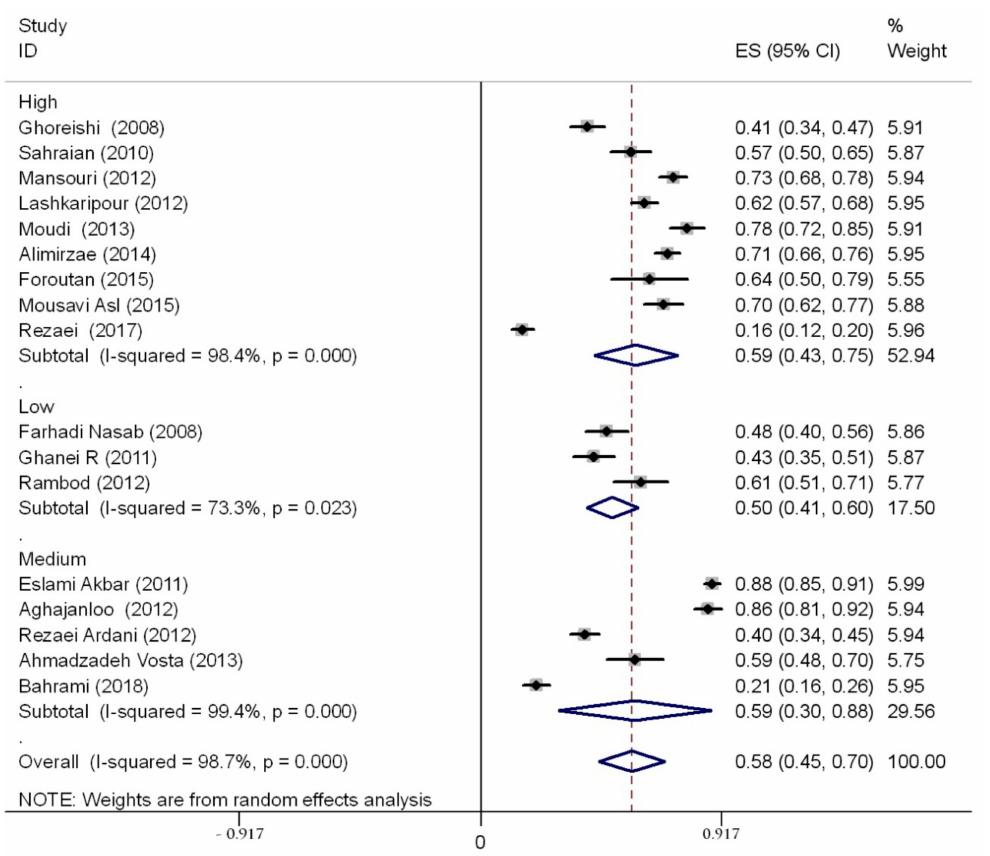
Figure 5. Sub-group analysis performed based on study quality. Table 4. A qualitative analysis of determinants of sleep disturbances among medical and health professions